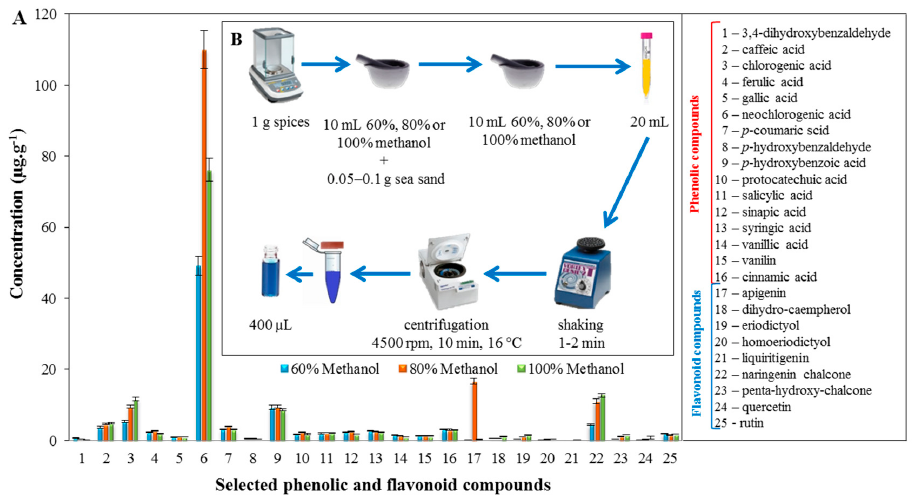
Figure 2. ( A ) Determination of the concentration of selected phenolic and flavonoid compounds in the extract from caraway seeds; ( B ) scheme for preparing the sample for LC/MS analysis.